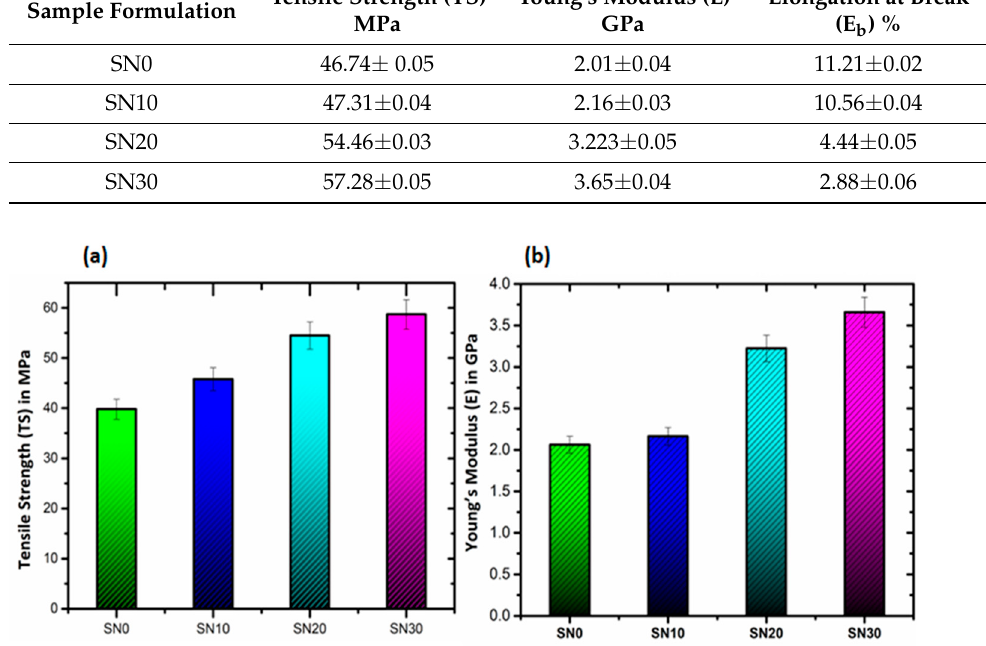
Figure 7. Tensile properties of PS and PS/m-BN composites are shown in ( a ) Tensile strength (TS) in MPa and in ( b ) Young’s modulus (E) in GPa.